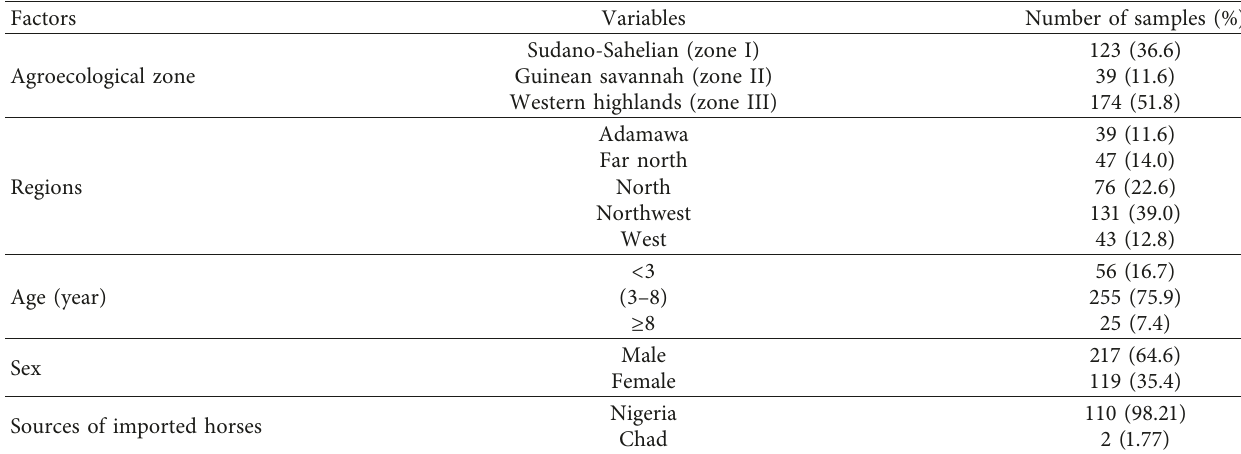
Table 1: Distribution of samples collected in the study